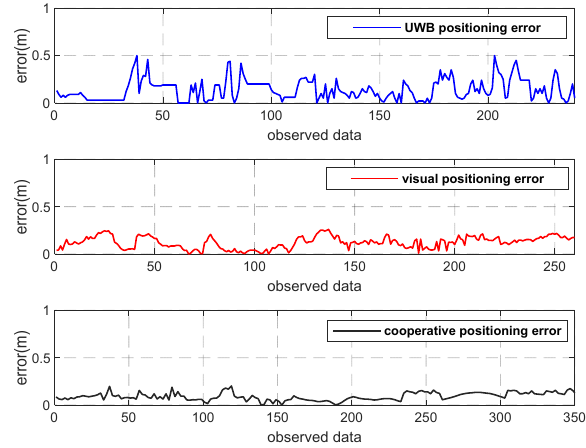
Figure 10. Error of the X -axis.